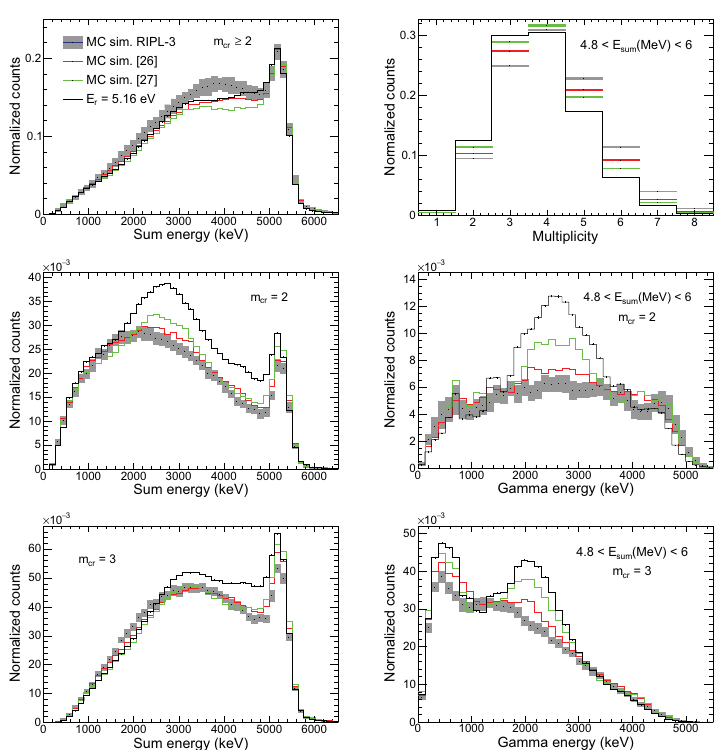
Figure 5. Comparison of experimental data to simulations using the LD and PSF models as recom- mended in RIPL-3 database [18] (grey filled), and as published in Refs. [26] (red line) and [27] (green line). The left column shows the total deposited energy spectra while on the right the multiplicity distri- bution and multi-step γ -ray energy spectra are shown. The resonance energy as well as the multiplicity and sum-energy conditions are specified in the